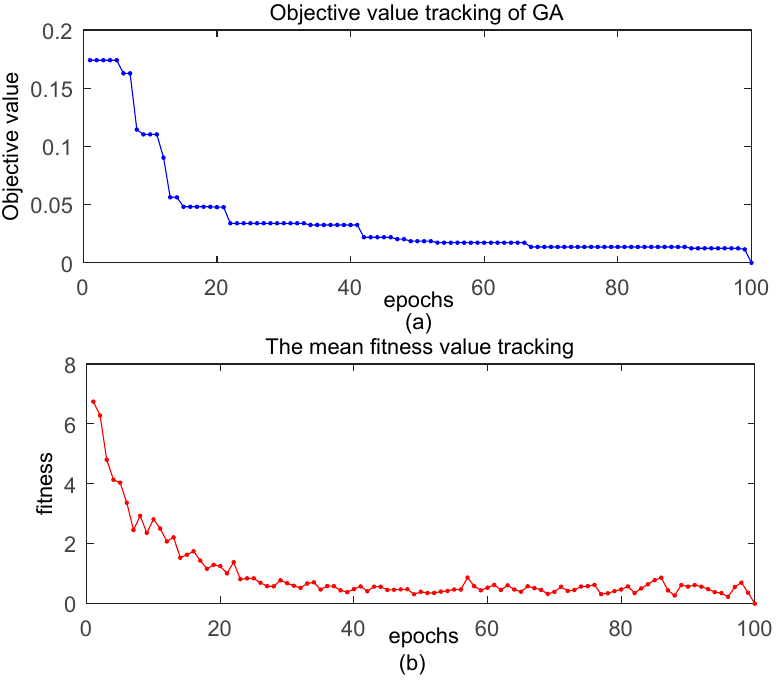
Figure 6. Genetic algorithm performance tracking. ( a ) Objective value tracking ( b ) The mean fitness value tracking.